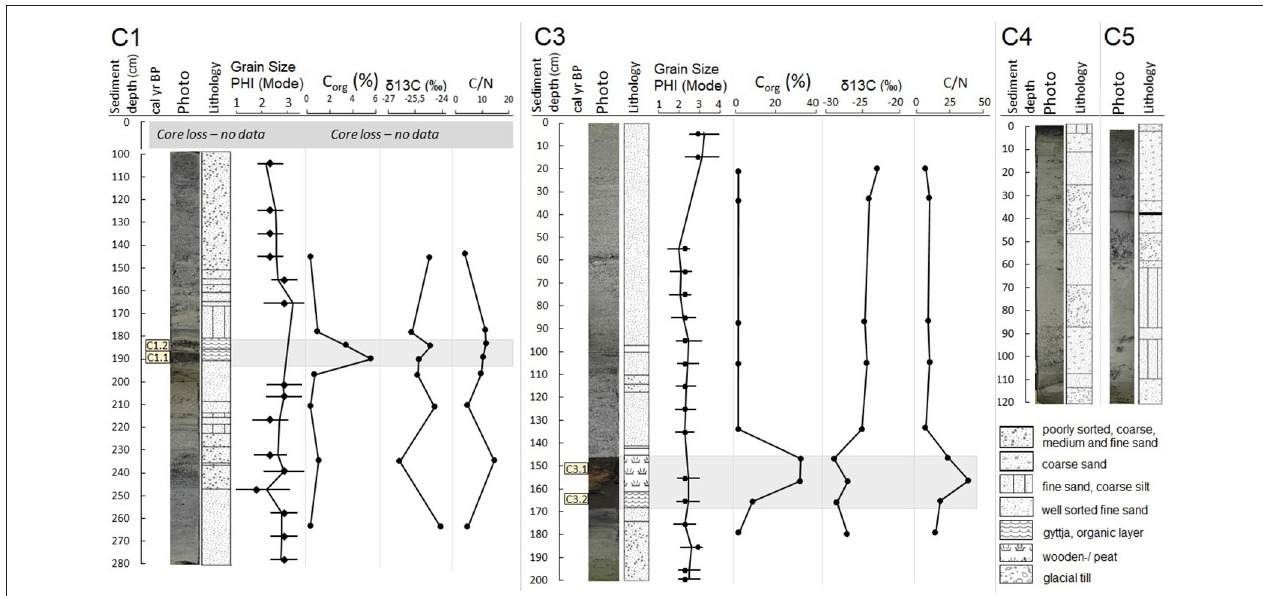
FIGURE 4 | Sediment depths (cm), radiocarbon age-dating, photographs, lithology, grain size distribution, organic carbon content (%), isotope ratio δ 13 C ( ‰ ), Carbon/Nitrogen ratios (C/N) of the 4 offshore sediment cores (C1, C3, C4, C5) retrieved from the study